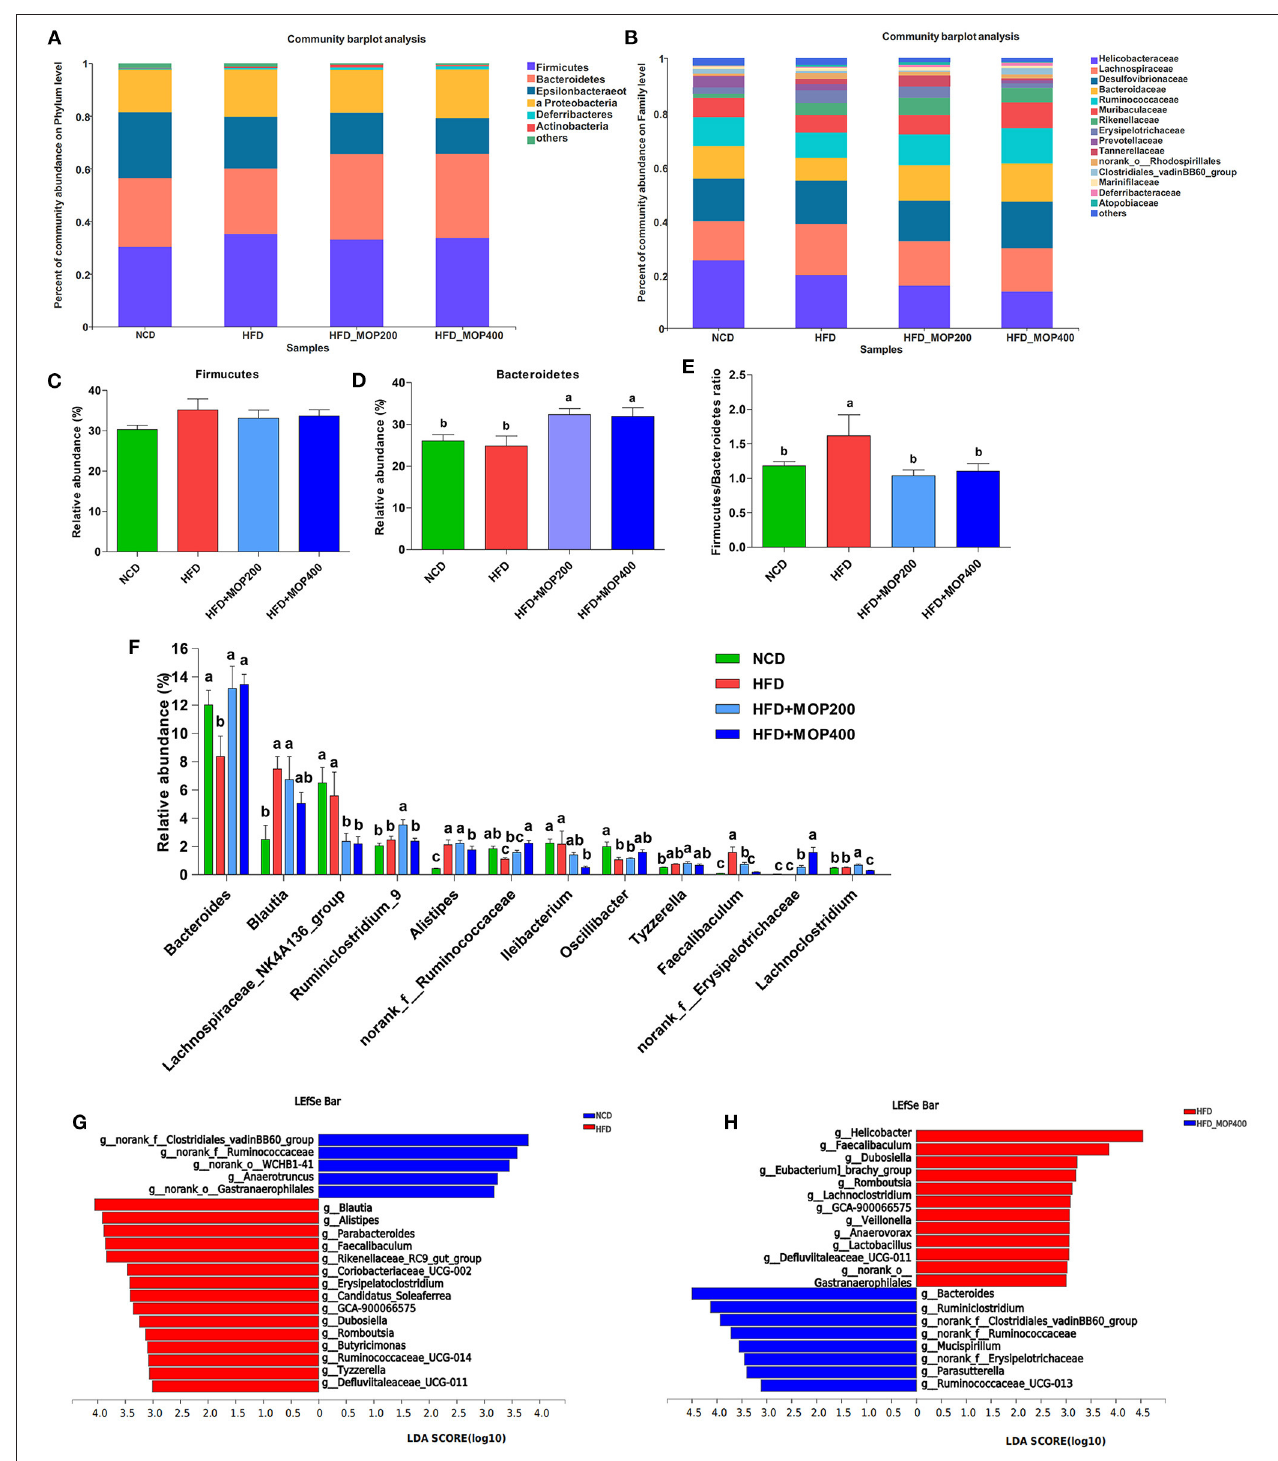
FIGURE 7 | MOP affects the relative abundance of gut microbiota at the phylum and family level in HFD-fed mice ( n = 8 mice/group). Bacterial taxonomic profiling at the phylum (A) and family (B) levels from different experimental groups. The relative abundance of Firmicutes (C) and Bacteroidetes (D) ; (E) The Firmicutes to Bacteroidetes (F/B) ratio in different groups; (F) Comparisons of relative abundance of the bacterial genera. The LEfSe analysis of the gut microbiota differed between NCD and HFD groups (G) , and between HFD and HFD + MOP 400 groups (H) . The histogram showed the lineages with LDA values of 3.0 or higher as determined by